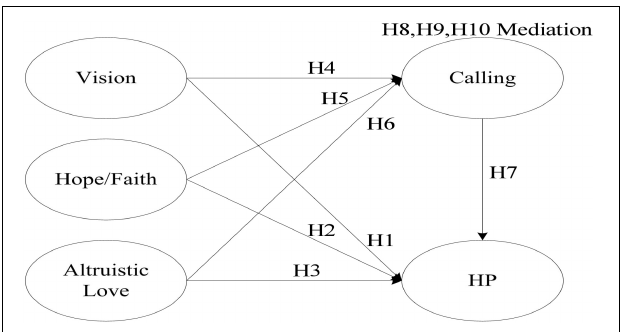
FIGURE 1 | Proposed conceptual framework.